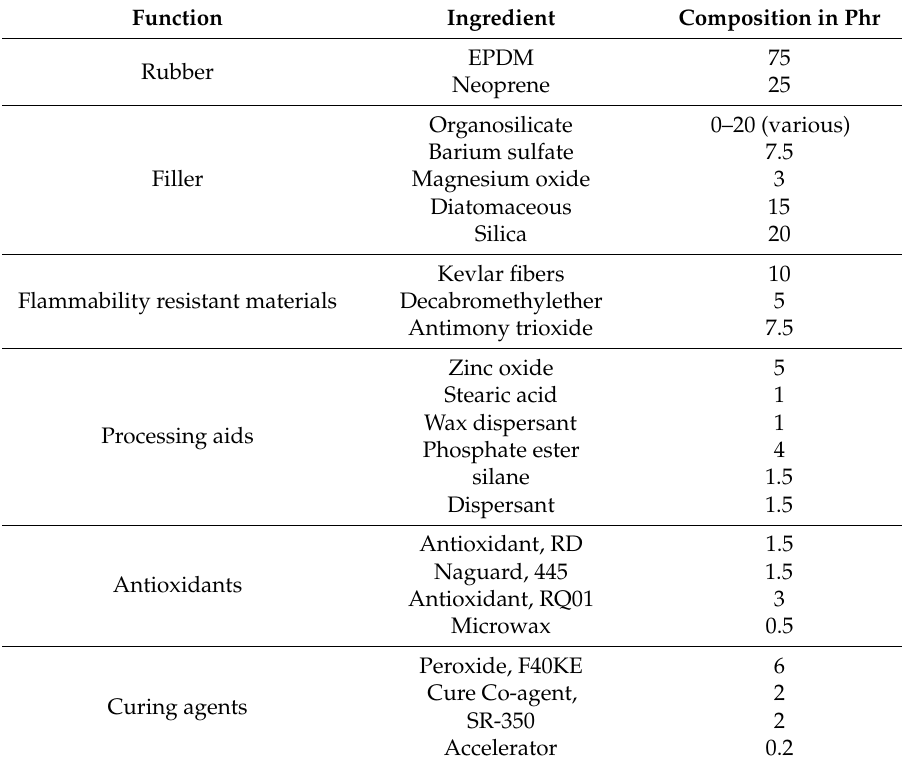
Table 3. EPDM/CR